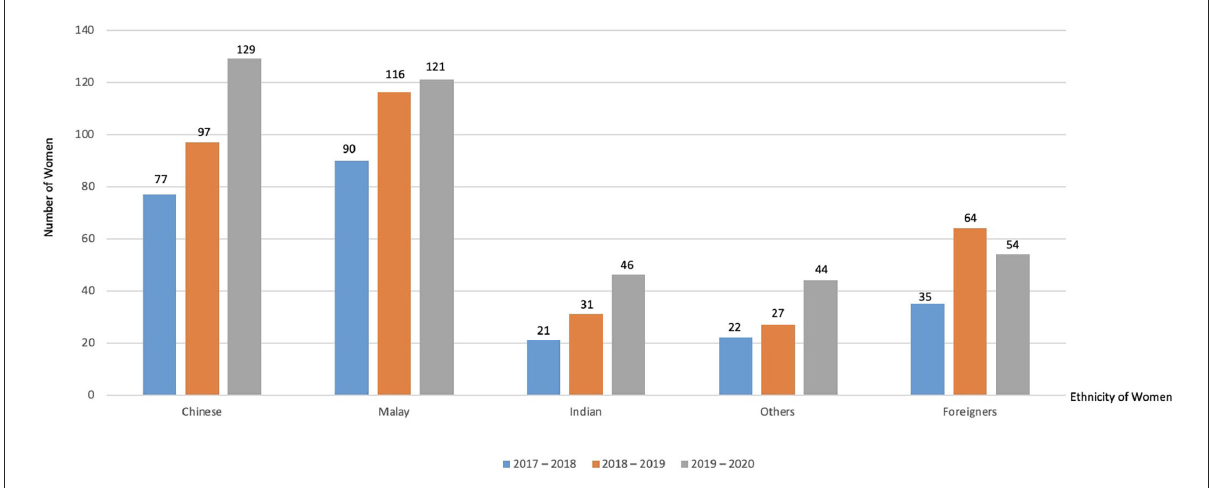
FIGURE1 Year-on-year ethnic distribution of women seeking referrals for unitended pregnancy (July 2017–June 2020).